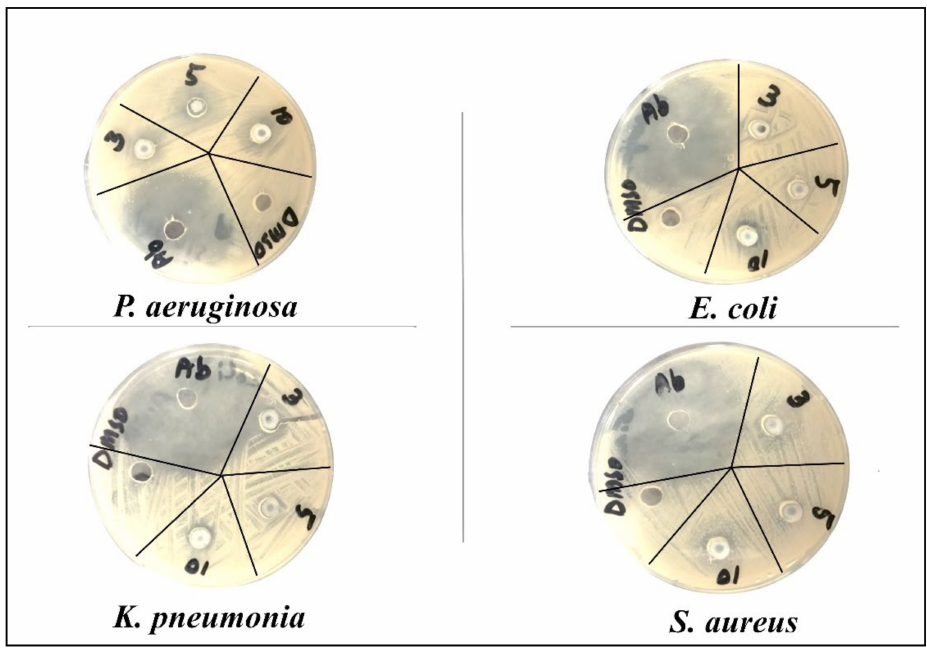
Figure 9. Zone of inhibition formed by Zn-doped CuO-NSs against different